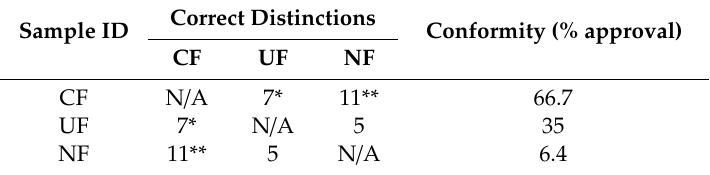
Table 1. Number of correct distinctions between samples and conformity ratings provided by the sensory analysis panellists upon four days of sample storage. Distinctions marked with * and ** are di ff erent between themselves with a significance level of 0.1 and 0.001,